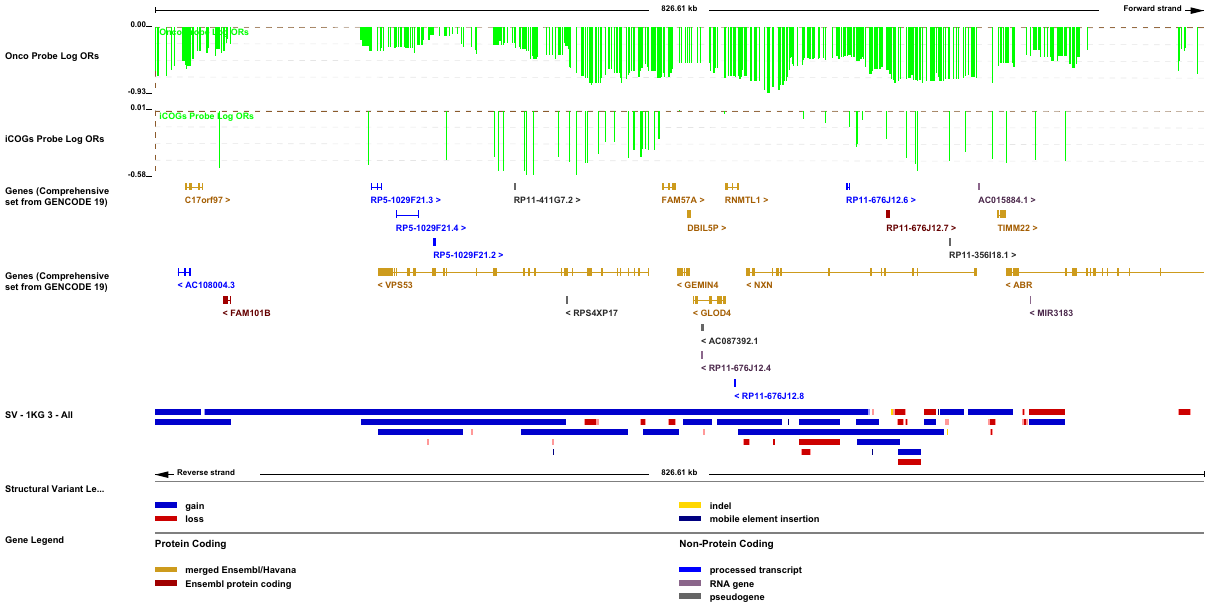
Fig. 3 Associations with duplications at the 17p13.3 locus. Log odds ratios for individual probes from Oncoarray and iCOGs are shown at the top in green. Genes from the Ensembl browser are shown in the next row, followed by structural variants identi fi ed by the 1000 Genomes Project with duplications in blue and deletions in